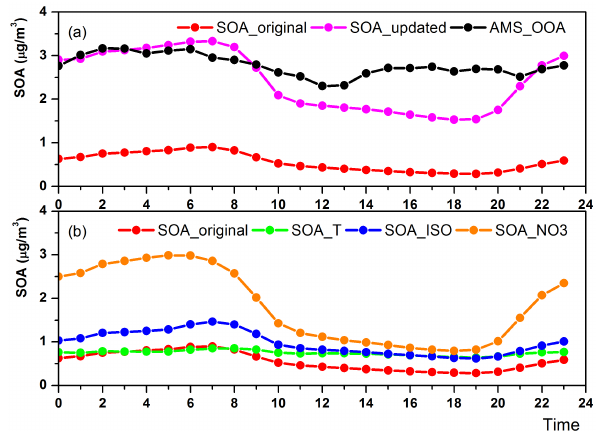
Fig. 8. Mean diurnal profiles of observed and modeled SOA con- centrations in Cabauw from 5–29 May 2008. (a) Black: observa- tion; red: simulation results of original SORGAM; pink: results of the updated SOA module. (b) Green: original SORGAM with tem- perature functions; blue: original SORGAM with isoprene; orange: original SORGAM with NO 3 chemical pathways.